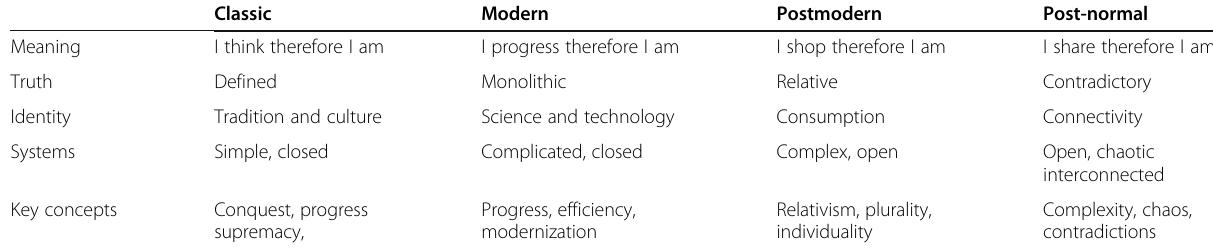
Table 2 Different perceptions and attitudes towards the